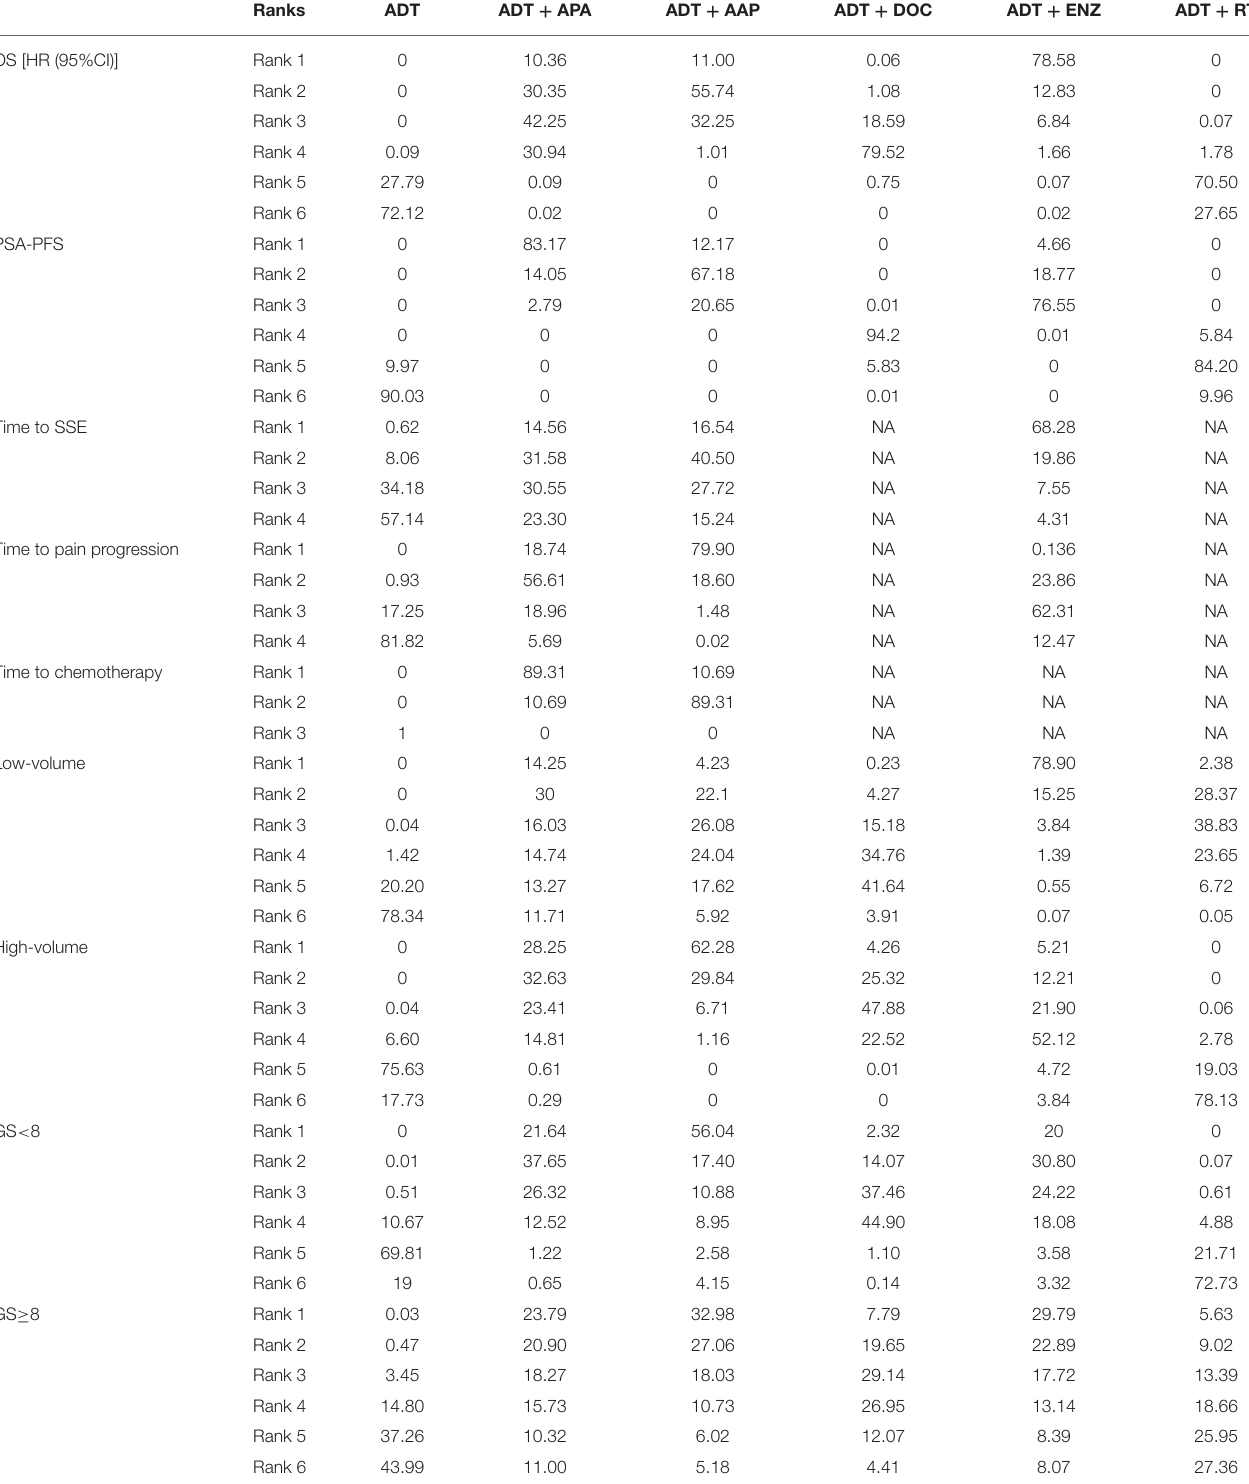
TABLE 3 | Ranking results of all comparisons.